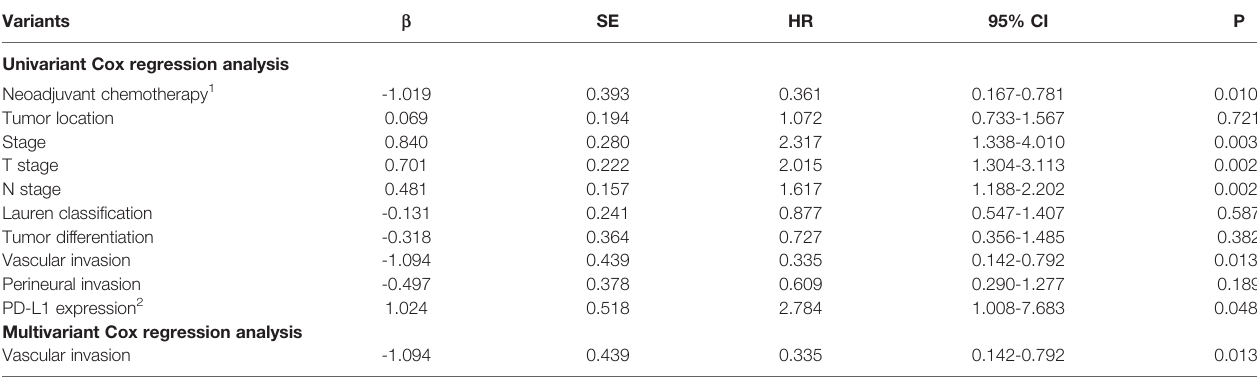
TABLE 2 | Results from Cox regression analysis for